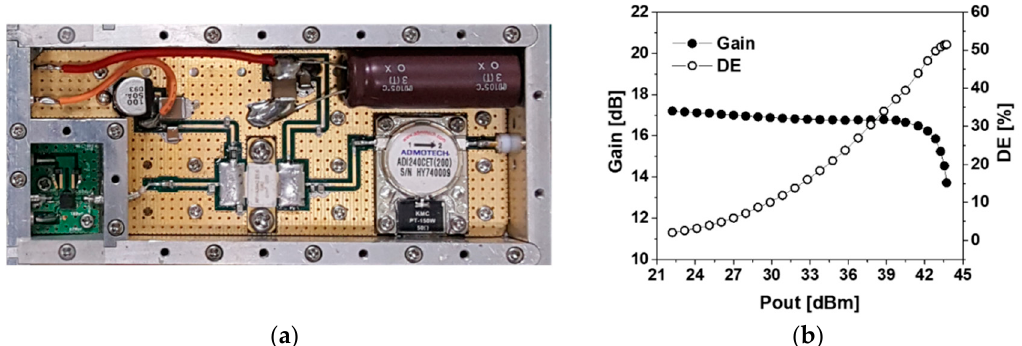
Figure 3. ( a ) a photograph of two stage power amplifier ( b ) RF measurement results of main stage amplifier .